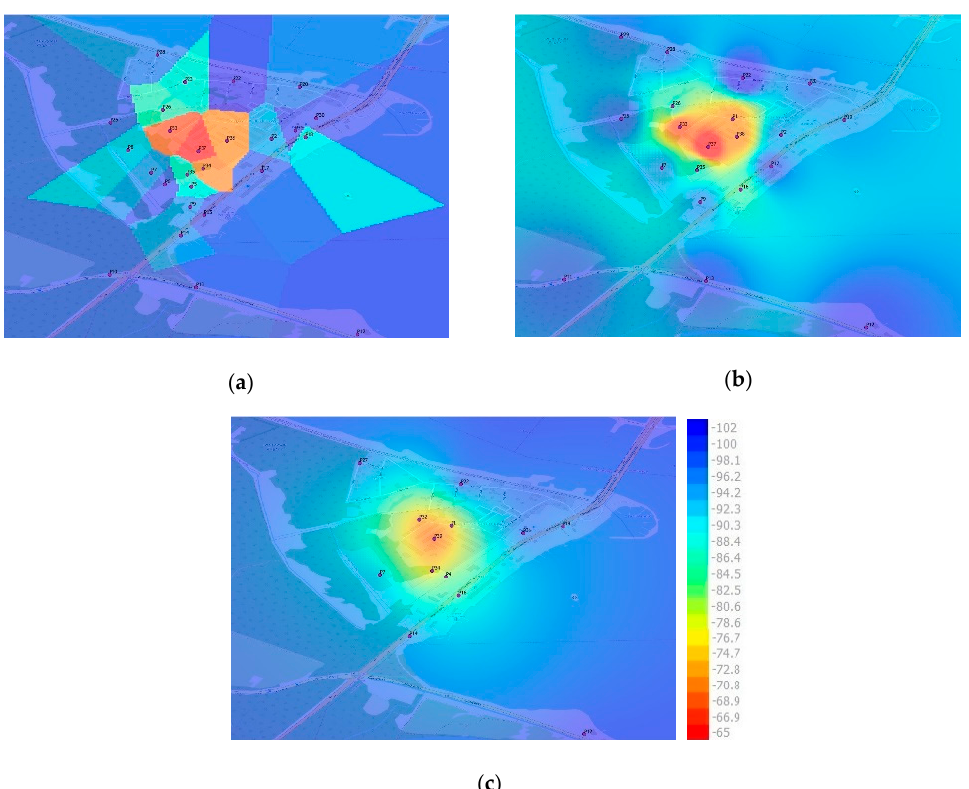
Figure 3. Exemplary maps constructed for selected interpolation techniques and various number of sensors (signal level in dBm): ( a ) 26 sensors—Nearest Neighbor (NN); ( b ) 20 sensors—Inverse Distance Weighting (IDW) p3; ( c ) 13 sensors— Kriging.